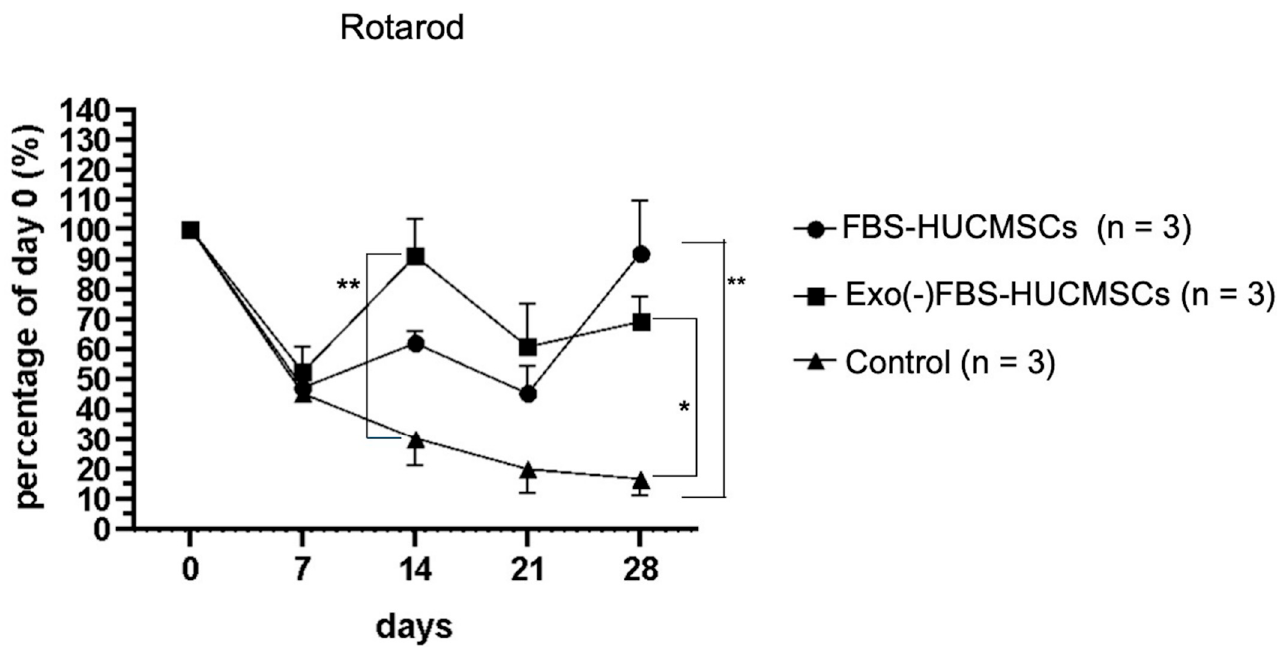
Figure 4. Behavior test (rotarod) of mice treated with exosome-containing (FBS-HUCMSCs) or exosome-depleted FBS-cultured HUCMSCs (Exo(-)FBS-HUCMSCs) or without HUCMSCs treatment (control). The stay time on the rotarod was recorded on days 0, 7, 14, 21, and 28. Day 0 was osteoarthritis induction day. n = 3 mice in each group. ** p < 0.01, * p < 0.05. HUCMSCs were derived from the same donor. FBS: fetal bovine serum.